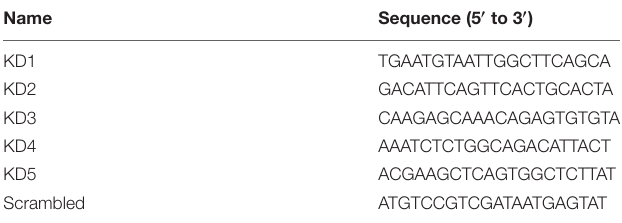
TABLE 3 | Myo16 knockdown target